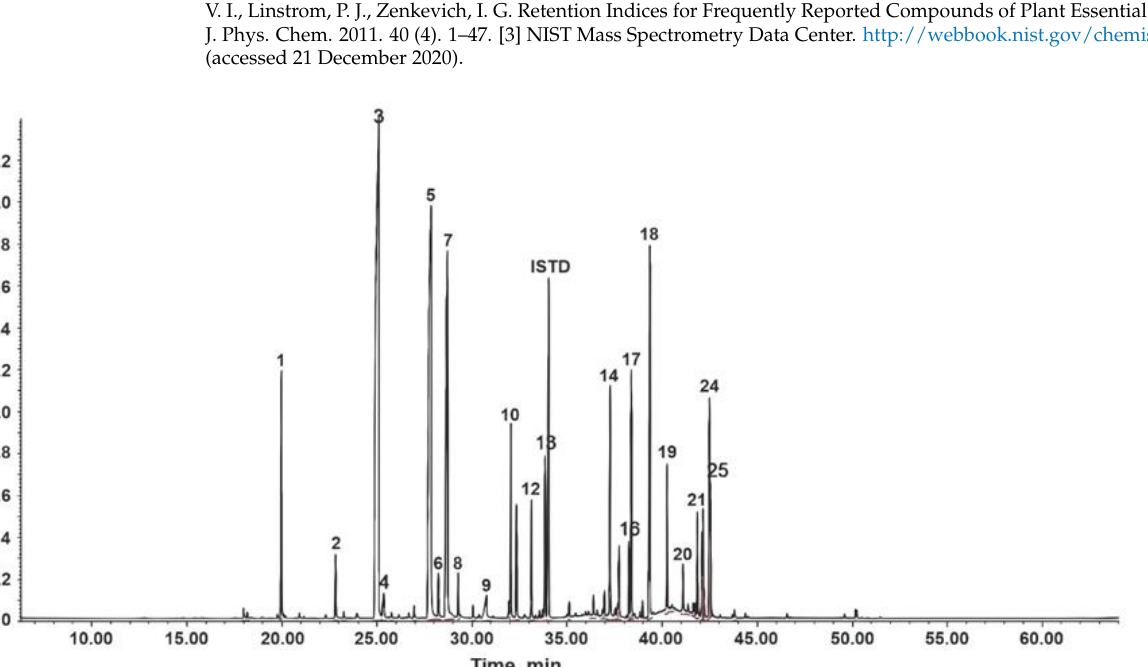
Figure 1. Chromatographic profile obtained by GC-MS (full scan) of C. nardus EO. Column DB-5MS (60 m), split injection 1:30, MSD (EI, 70 eV). Peaks: 1: Limonene, 2: Linalool, 3: